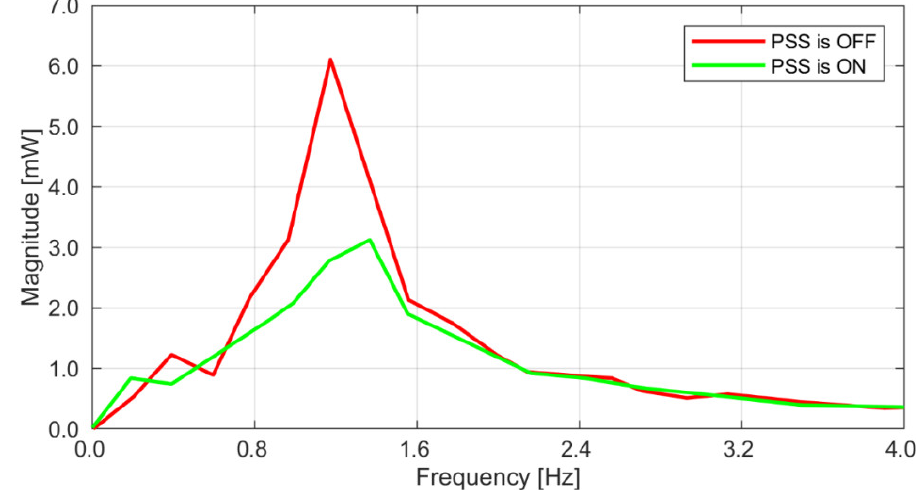
Figure 8. Impulse test fast Fourier transform [28].